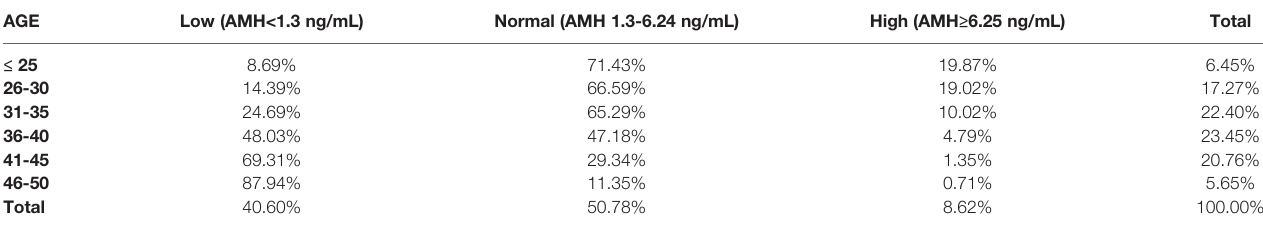
TABLE 4 | Distribution of patients based in their levels of AMH (ng/mL). AGE Low (AMH<1.3 ng/mL) Normal (AMH 1.3-6.24